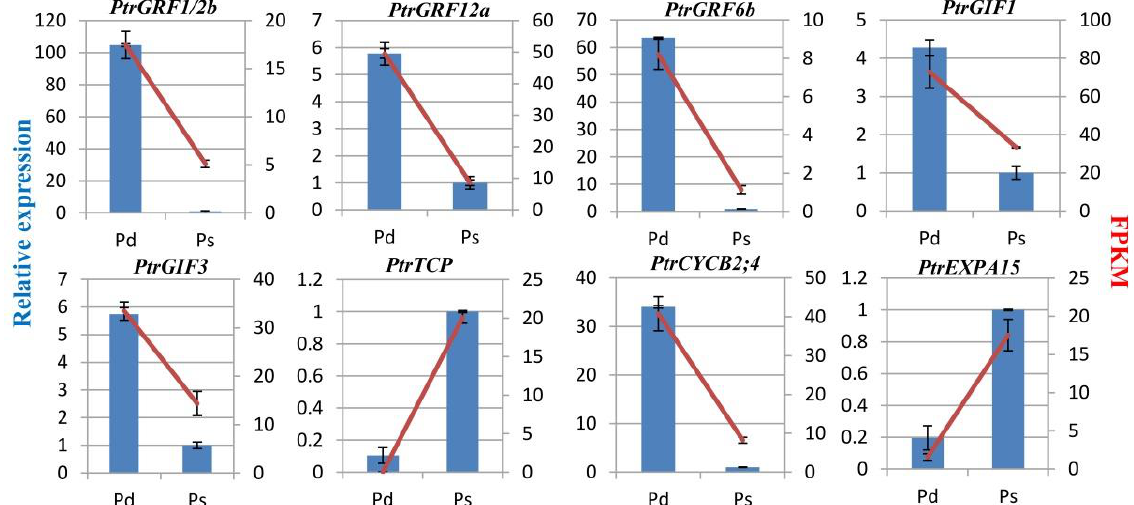
Figure 5. qRT-PCR validation of differentially expressed genes related to leaf size. The left blue histogram represents the qRT-PCR results. The red broken line on the right represents the FPKM of the transcriptome. PtrGFR1 / 2b (Potri.014G007200), PtrGRF6b (Potri.018G065400), PtrGRF12a (Potri.001G114000), PtrGIF1 (Potri.019G013100), PtrGIF3 (Potri.002G177600), PtrTCP (Potri.T046300), PtrCYCD2;4 (Potri.002G010000), PtrEXPA15 (Potri.013G060800). Values are presented as means ± SD of three independent